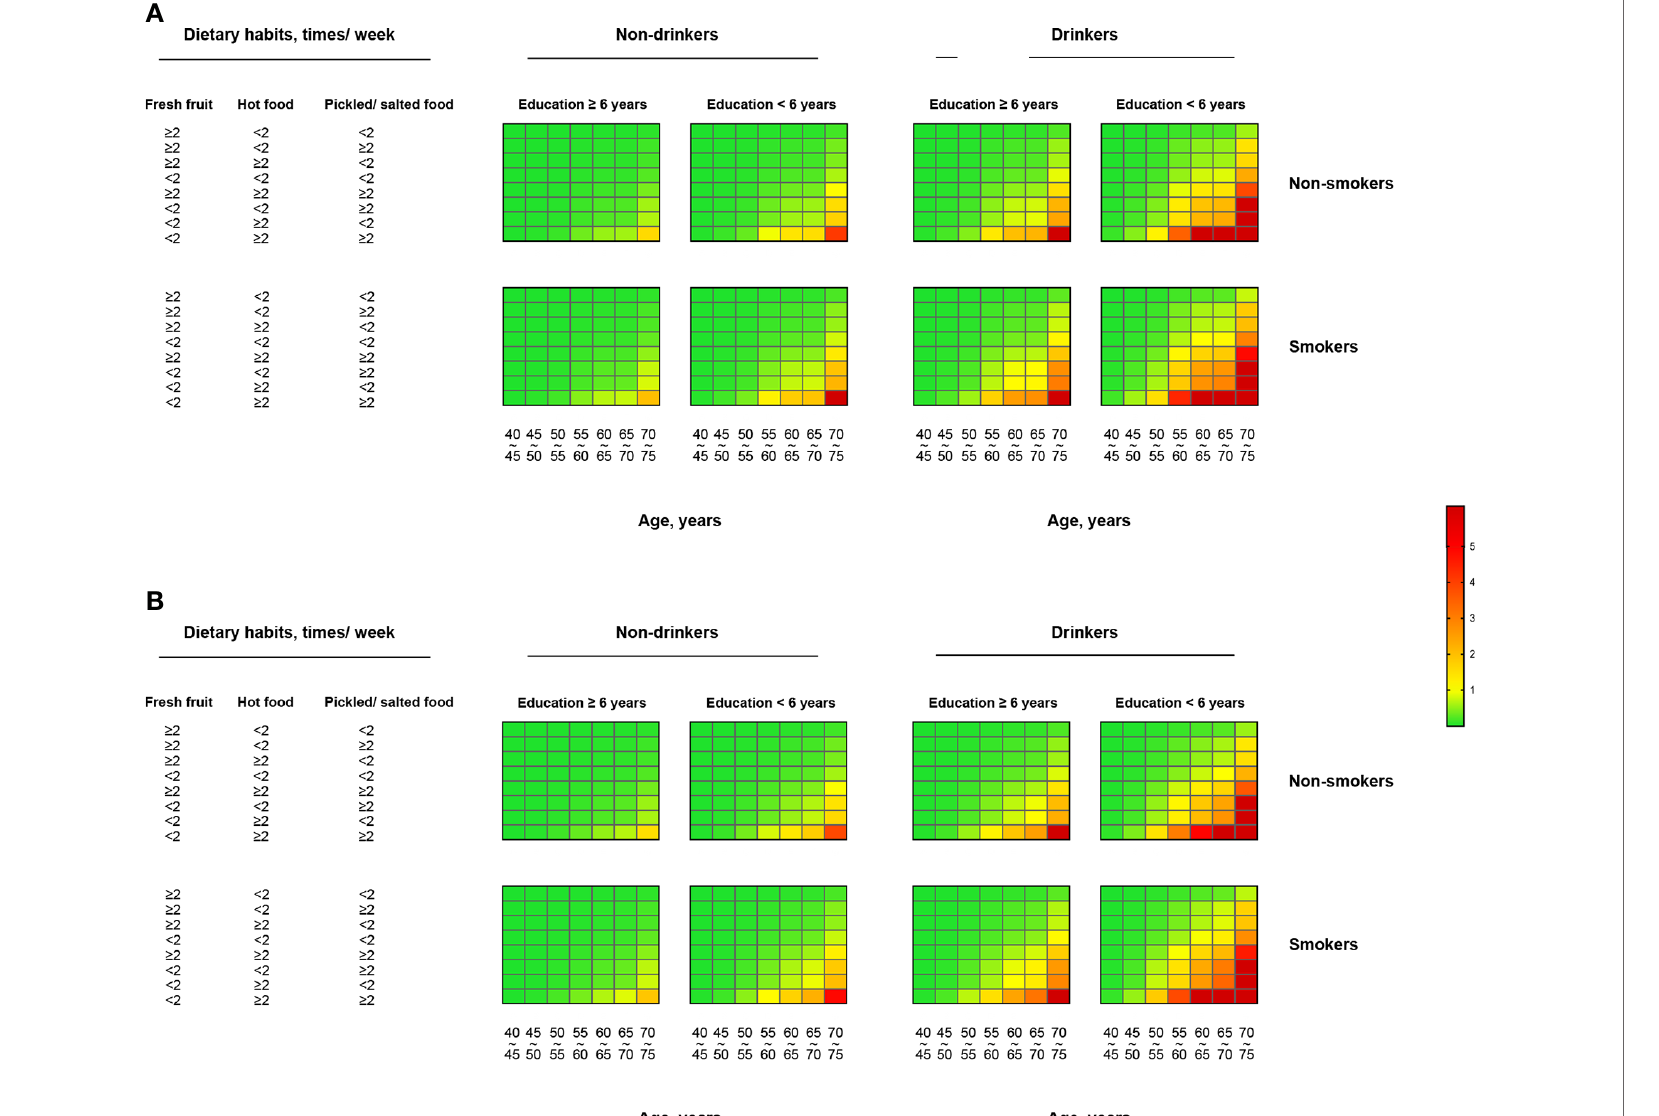
FIGURE 2 | Individualized absolute 5-year risk (%) of ESCC for (A) man and (B) woman, estimated from the relative risk model and local incidence and mortality rates. ESCC, esophageal squamous cell